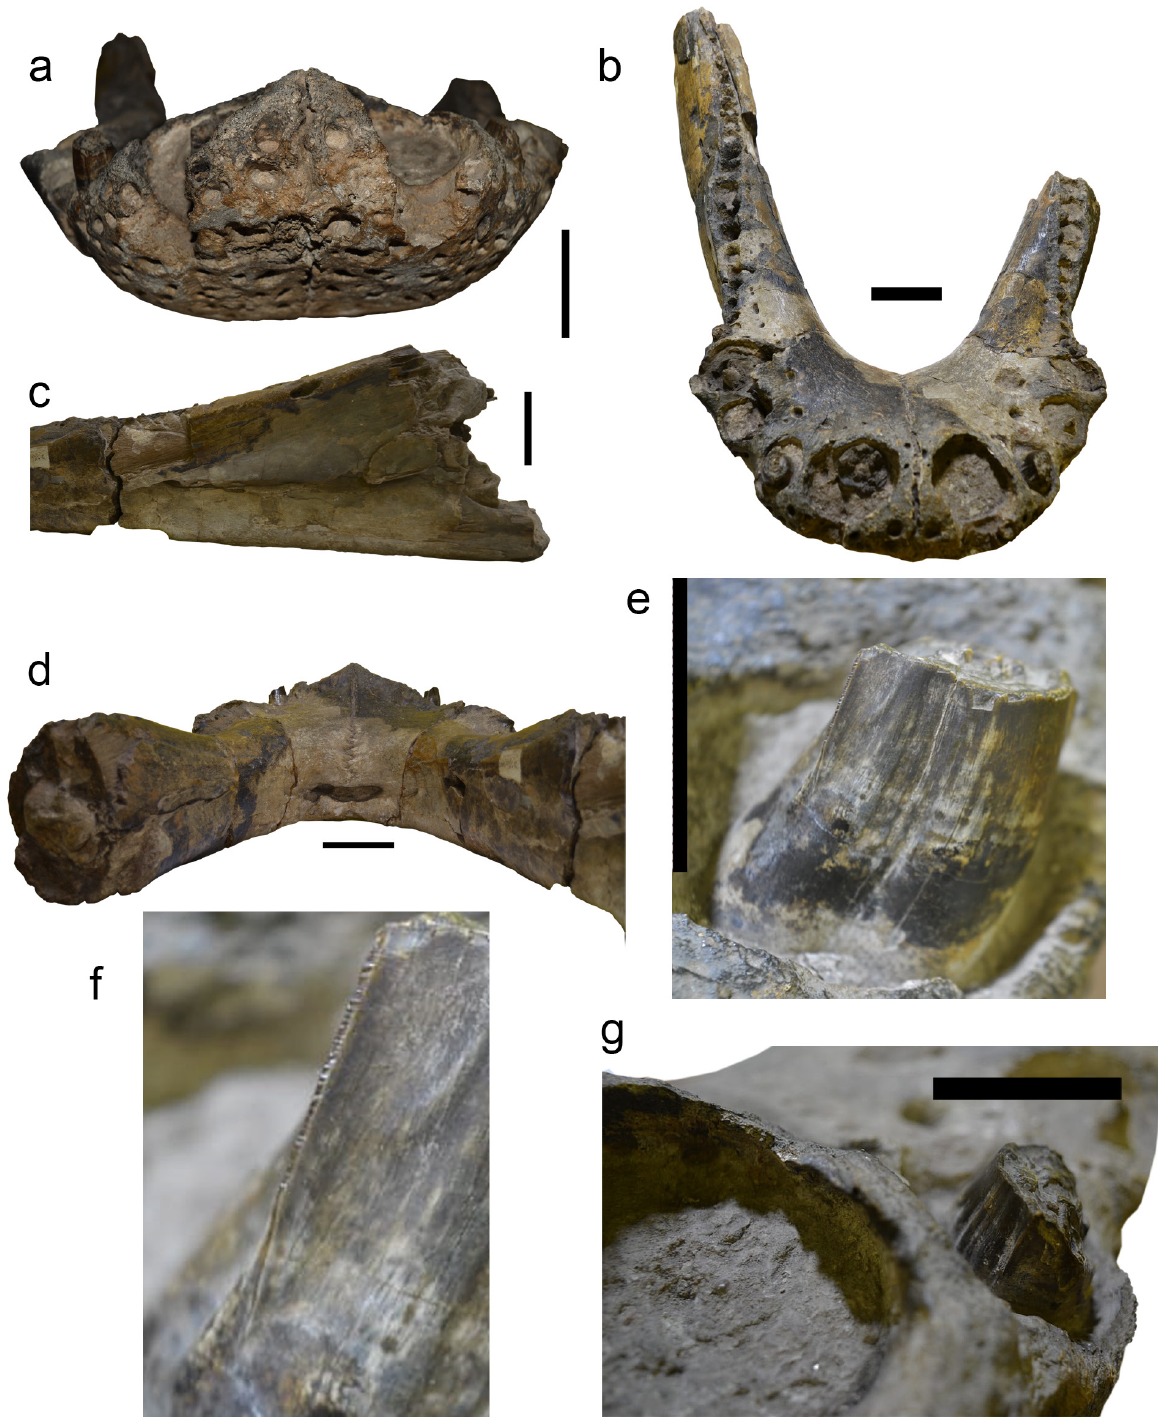
Figure 5. Detail of the mandible specimen of Purussaurus brasiliensis (DGM 527-R). a) anterior view of the in situ tooth of the left side second alveolus; b) labial view of the in situ tooth of the right side second alveolus; and, c) Zoom in the carinae of the tooth figured in b. Scale bar a and b: 5cm; c: